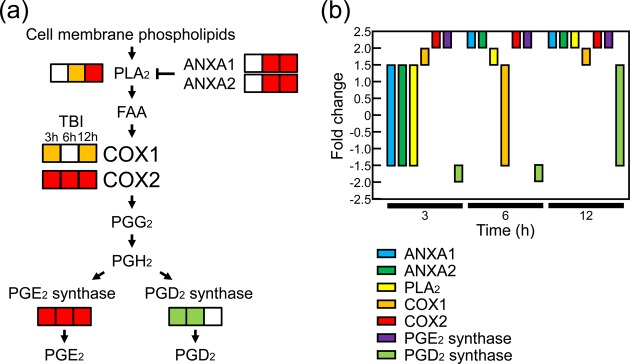
Pathway analysis of traumatic brain injury (TBI)-induced prostaglandin synthase and regulation. Panel (a) shows ratios of gene expression levels were compared between chips corresponding to 3, 6, and 12 h TBI and sham groups. Right-, center-, and left-side columns represent altered gene expression at 3, 6, and 12 h after TBI, respectively. Red, orange, white, and green columns represent fold change (FC) ≥ 2.0, 2.0 > FC ≥ 1.5, −1.5 ≥ FC > 1.5, and −2.0 ≤ FC < −1.5, respectively. The statistical analysis method is described in the experimental procedures. Results were considered significant if Z-score ≥ 0 and permute P ≤ 0.01. Panel (b) shows the FC of the 7 genes over time.